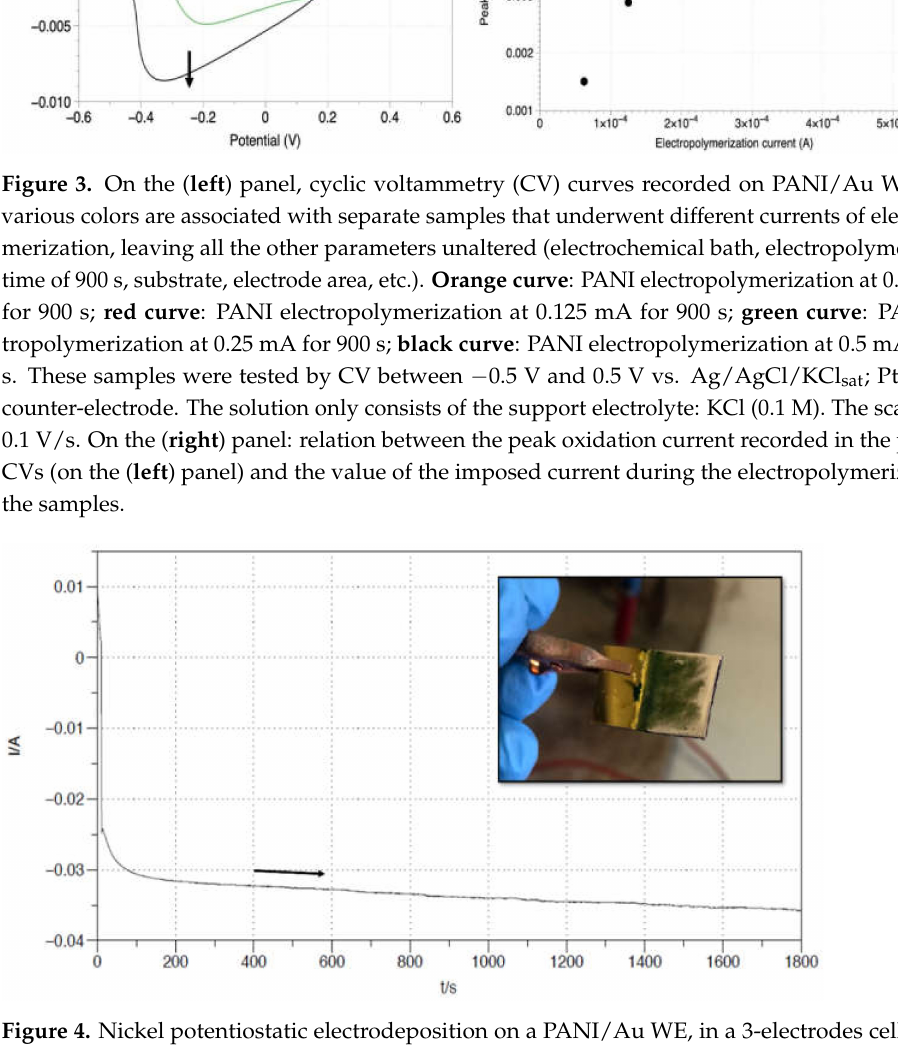
Figure 4. Nickel potentiostatic electrodeposition on a PANI/Au WE, in a 3-electrodes cell. Pt was used as CE, Ag/AgCl/KCl sat as Ref. The Watt’s Bath was used as electrolyte: nickel sulphate NiSO 4 (1 M), nickel chloride NiCl 2 (0.25 M), boric acid H 3 BO 3 (0.6 M), pH = 5. The imposed potential was − 1.4 V for 1800 s. The inset displays the produced